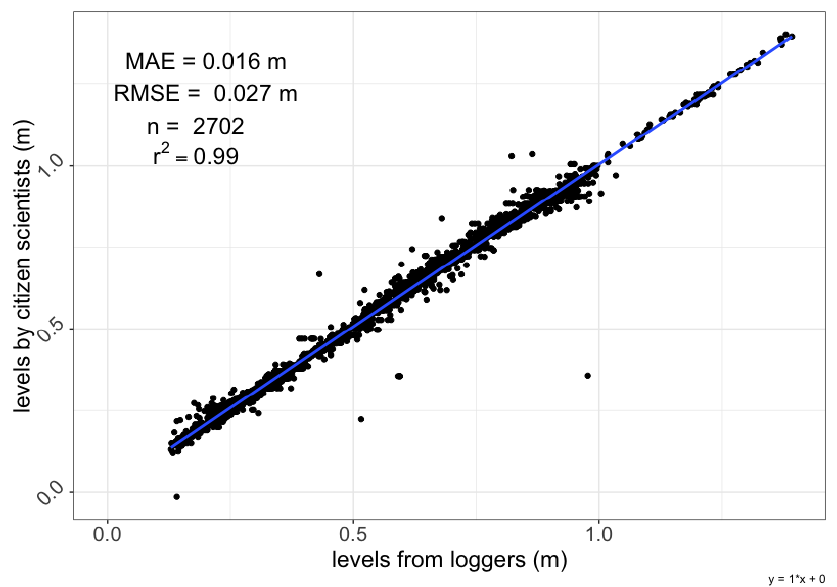
Figure 8. A scatterplot depicting the accuracy of citizen science measurements as compared to data collected by pressure transducers. The accuracy of citizen science measurements is very high, with MAE of only 1.6 cm. The accuracy of the pressure transducers themselves is ~0.8